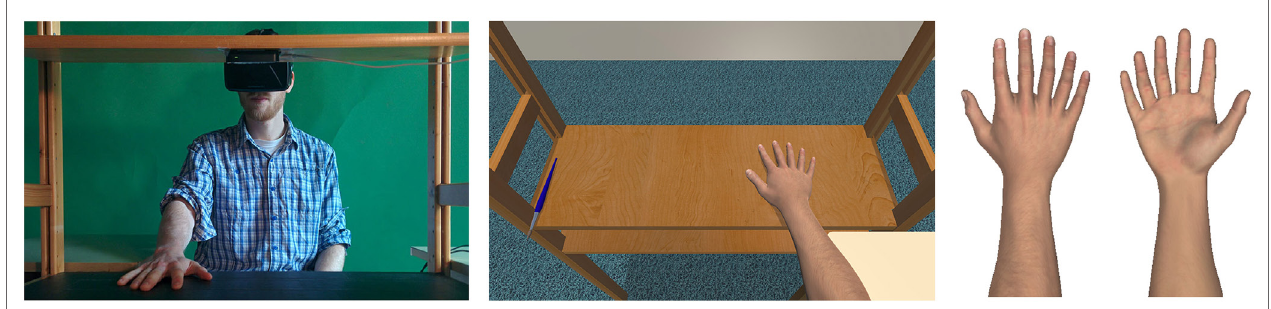
FigUre 1 | setup of the experiment . Left: physical experimental setup. Middle: corresponding virtual setup including the six-digit virtual hand used in the experiment. Right: six-digit virtual hand model used in the experiment.